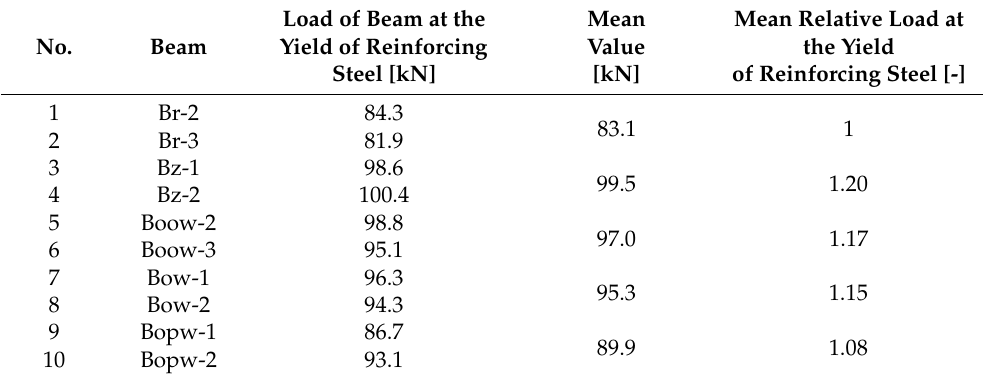
Table 5. Determination of the beginning of steel yielding of the main reinforcing bar.